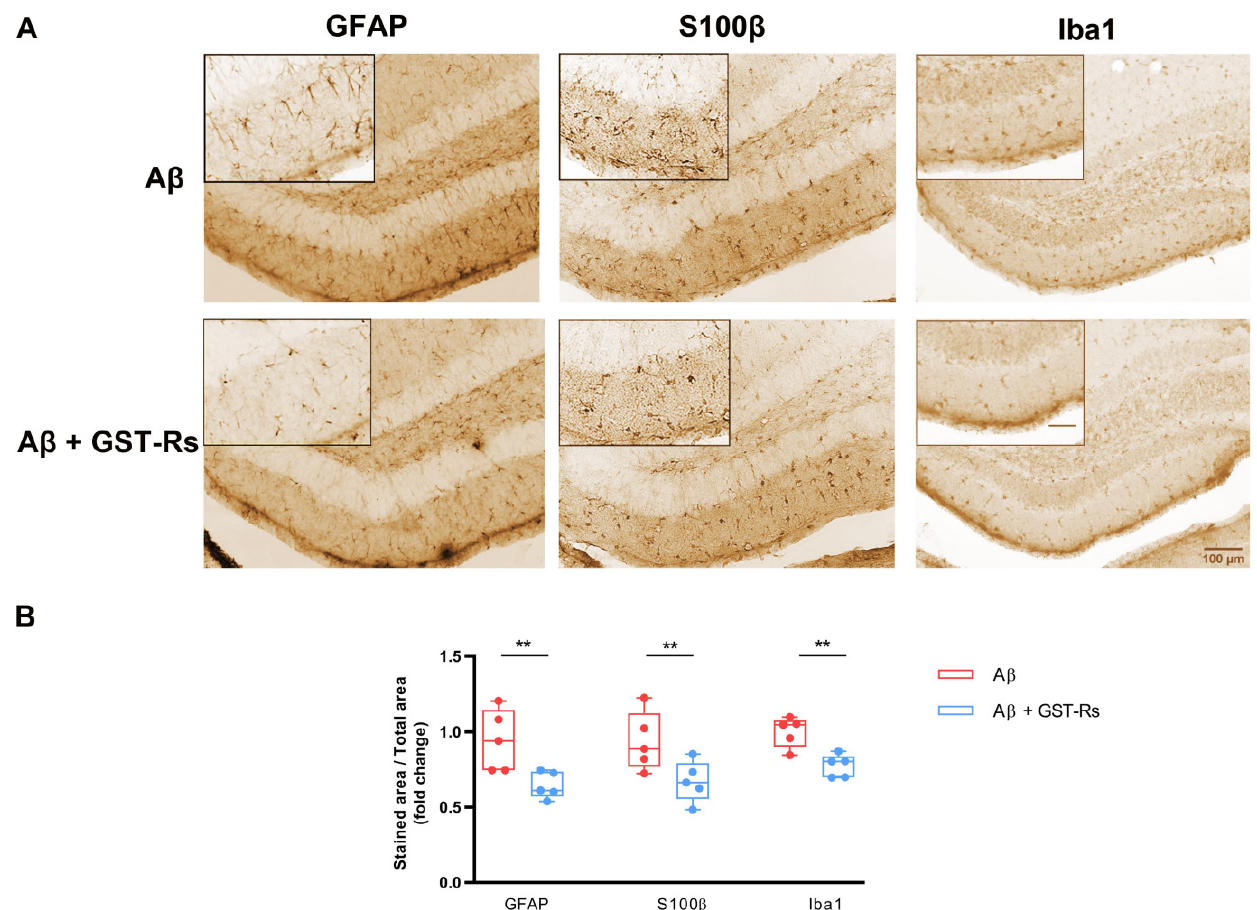
Figure 4. GST-R s polypeptide prevents gliosis in the DG of A β -injected mice. ( A ) Coronal sections of mouse brains were immunostained by DAB assay 7 days post-injection with A β or A β + GST-Rs. Photomicrographs show GFAP and S100 β immunolabeling in astrocytes and Iba1 immunolabeling in microglia of the dentate gyrus. Scale bar: 100 µm and Scale bar in zoom is 50 µm. It is included in caption. 50 µm ( B ) Box plot graphs show quantitative analysis of labelled areas for GFAP, S100 β and Iba1 under A β and A β + GST-R s in the DG. Data are presented as the mean ± S.E.M. Fifteen slices from five animals were analyzed per condition. ** p < 0.01 compared with A β -injected mice; unpaired Student’s test.